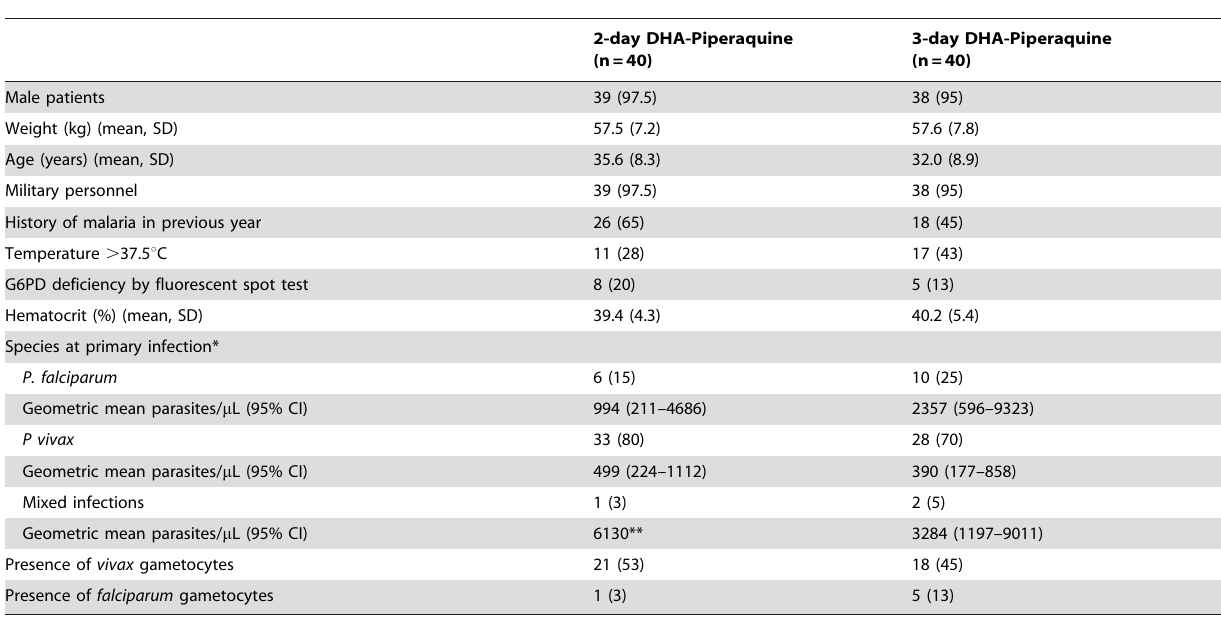
Table 1. Baseline characteristics of enrolled patients according to treatment